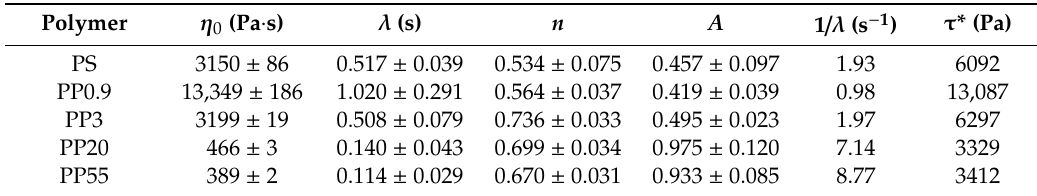
Table 6. Rheological parameters by the experimental fit of the modified Carreau–Yasuda model for the native polymers at 200 ◦